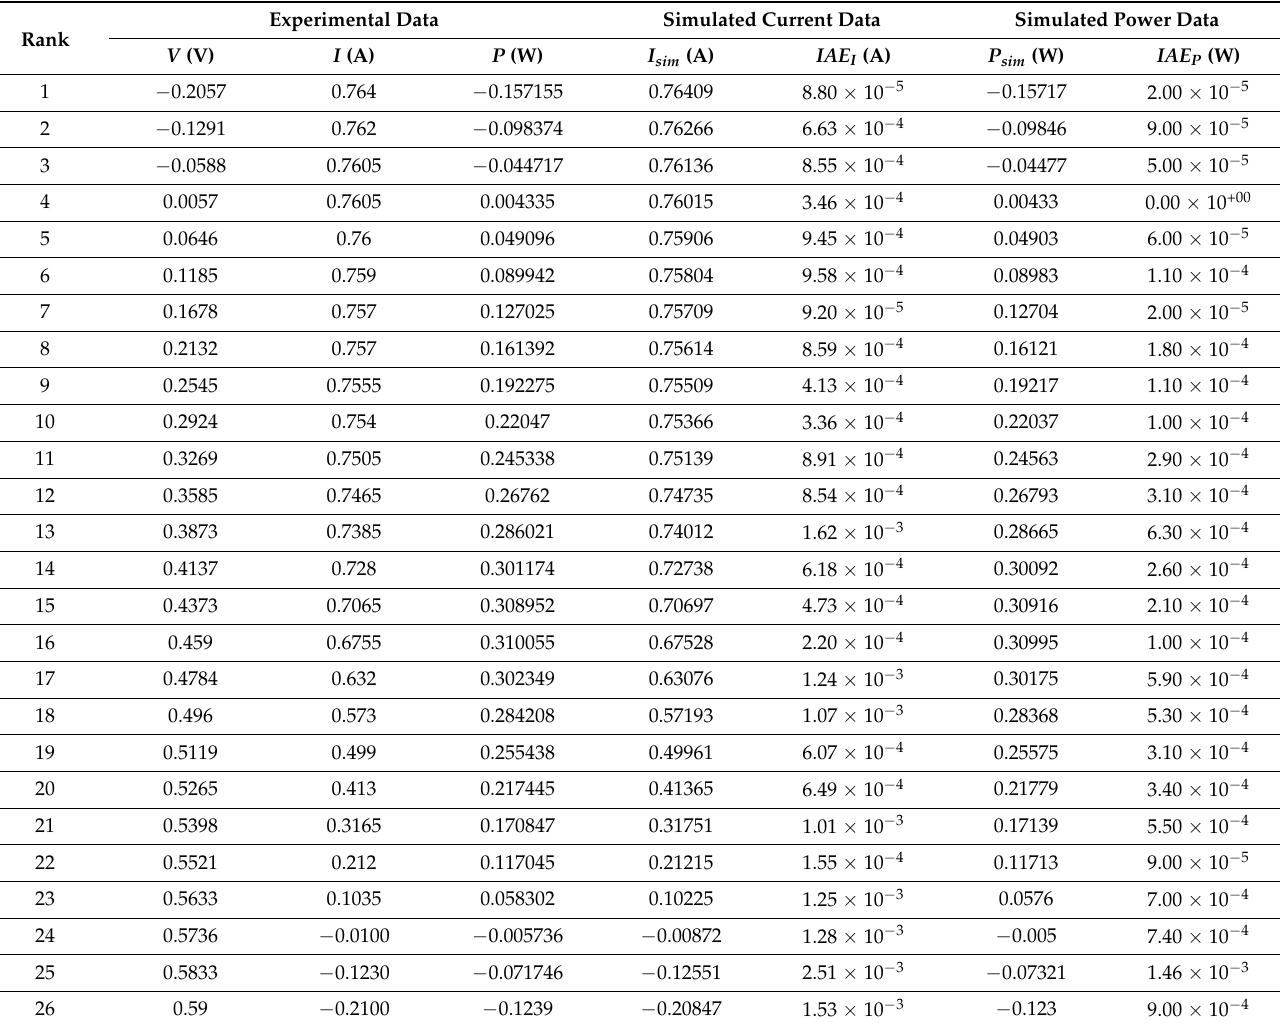
Table 8. Measured and simulated data of voltages, currents, and power and the absolute errors values using MECPO for